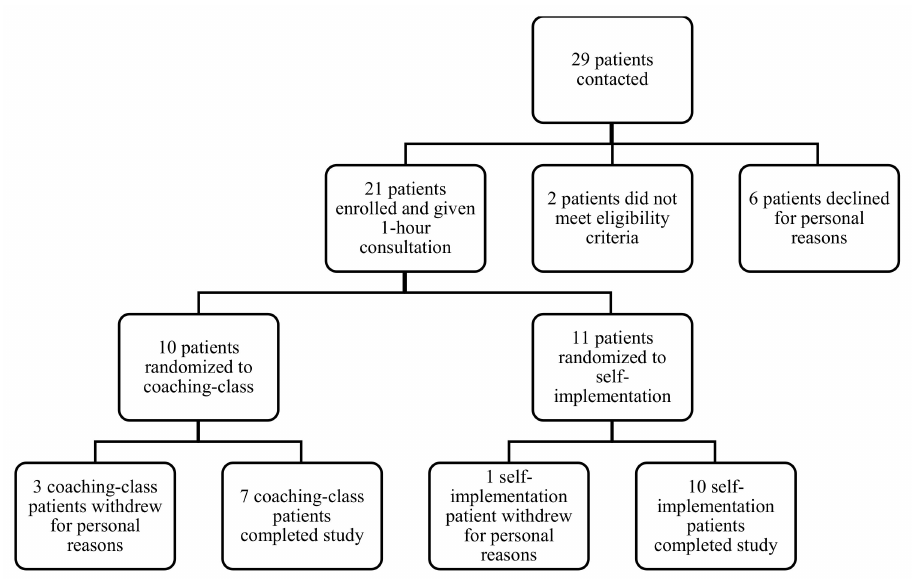
Figure 1. Patient Participation and Randomization. Table 1. Demographics of active